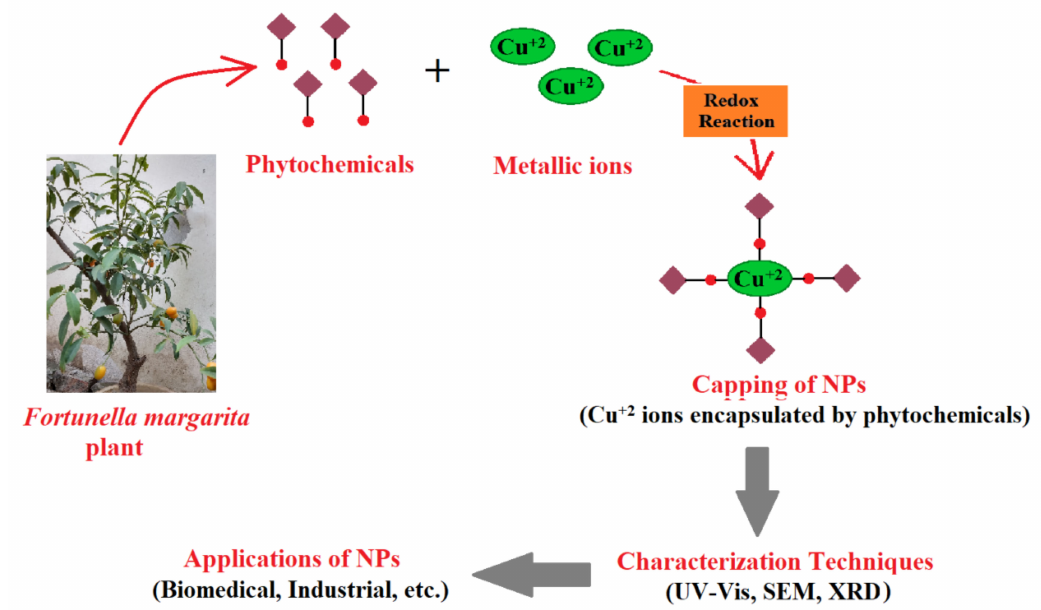
Figure 2. A diagrammatic sketch representing the mechanism and utilization of synthesized nanoparticles using plant